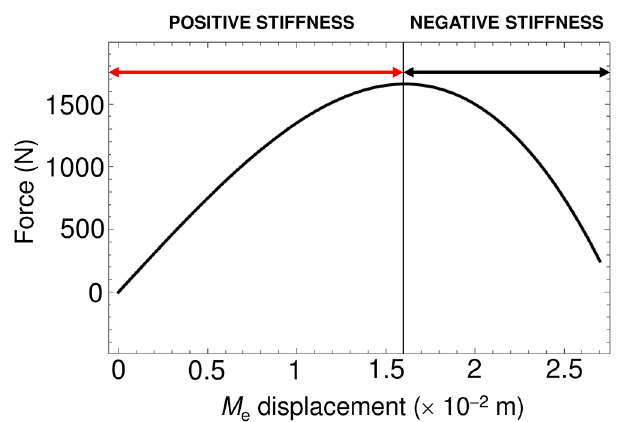
Fig. 4. Restoring force F vs. displacement amplitude of the external mass M e in a p.m.m. system with softening anharmonic springs ( k e(4) = (cid:1) 2 (cid:5) 10 8 N/m